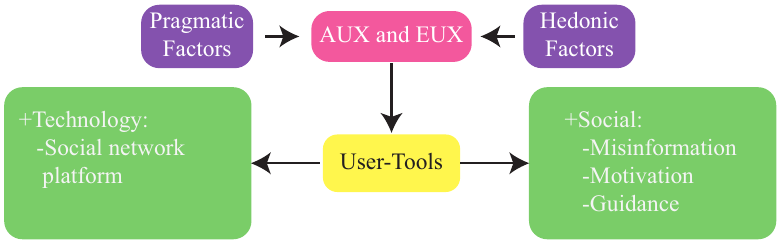
Figure 1. Design elements and influence of user-tools.